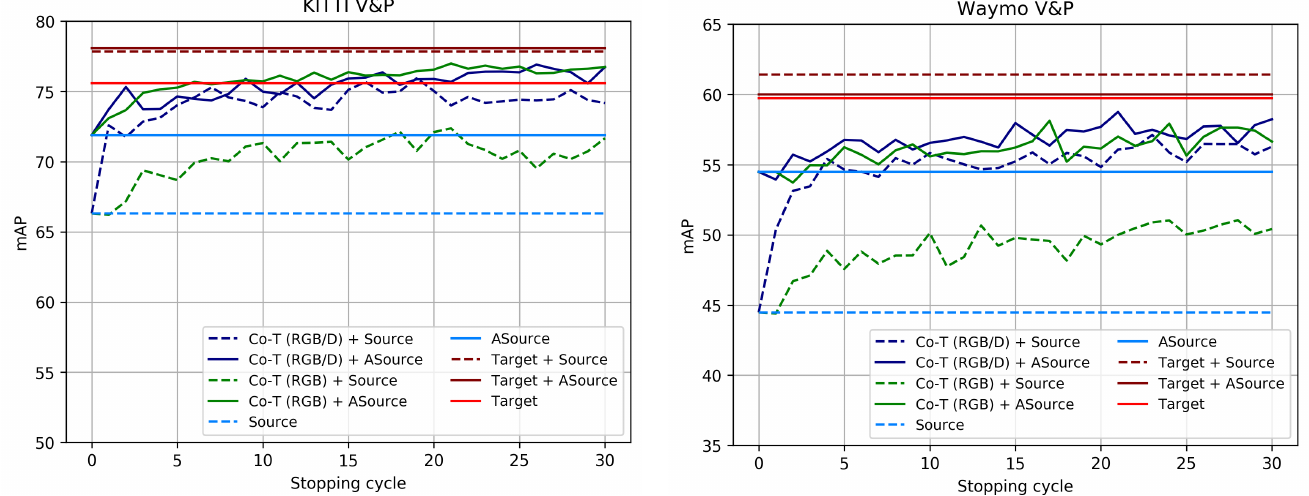
Figure 5. V&P detection accuracy of co-training approaches as a function of the stopping cycle. These plots are analogous to those in Figure 4 for the cases of using virtual-world data, i.e., both with domain shift (Source) and reducing it by the use of GANs (ASource). The Targets are the same as in Figure 4. These plots complement the results shown in Tables 5 and